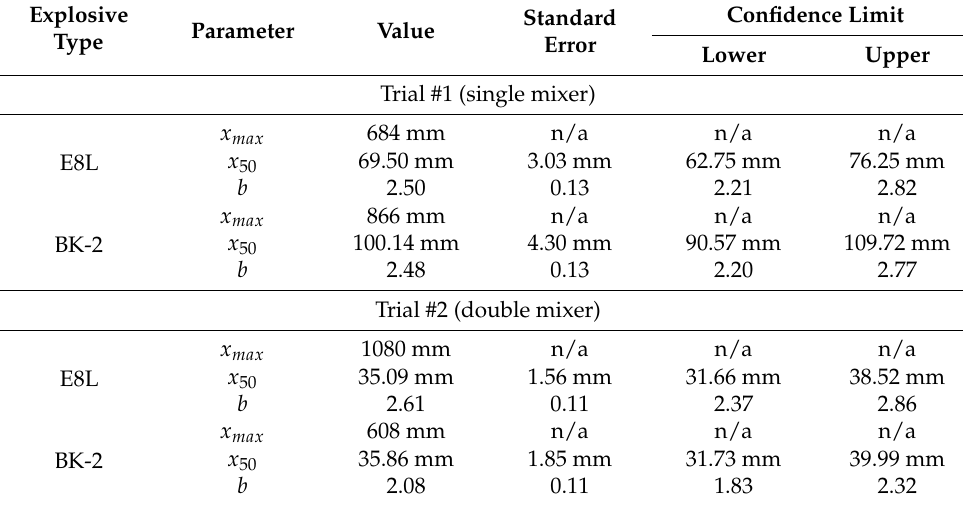
Table 5. Estimated model parameters of the distribution model for both